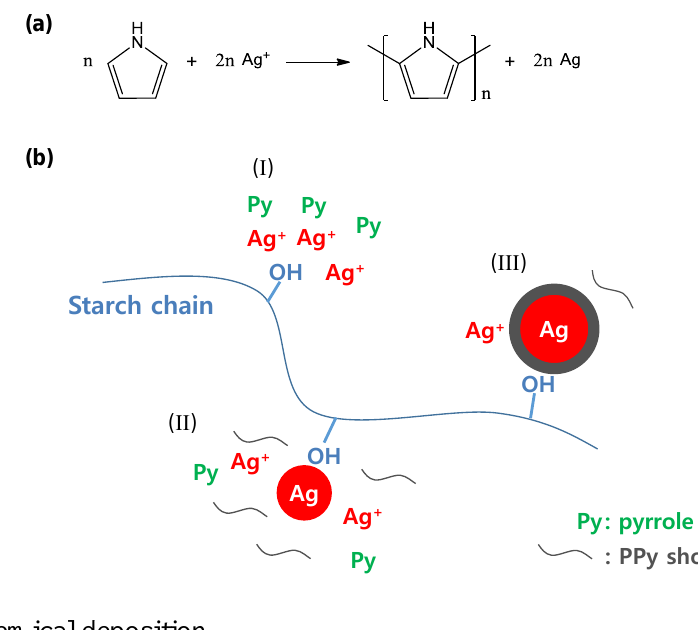
Figure 4. Schematic illustration of the formation mechanism of silver-PPy nanoparticles: ( a ) the scheme describing the chemical reaction between pyrrole and silver cation; ( b ) the reaction process could be divided into three stages (I, II, and III). Adapted with permission from [30]; Copyright 2012, American Chemical